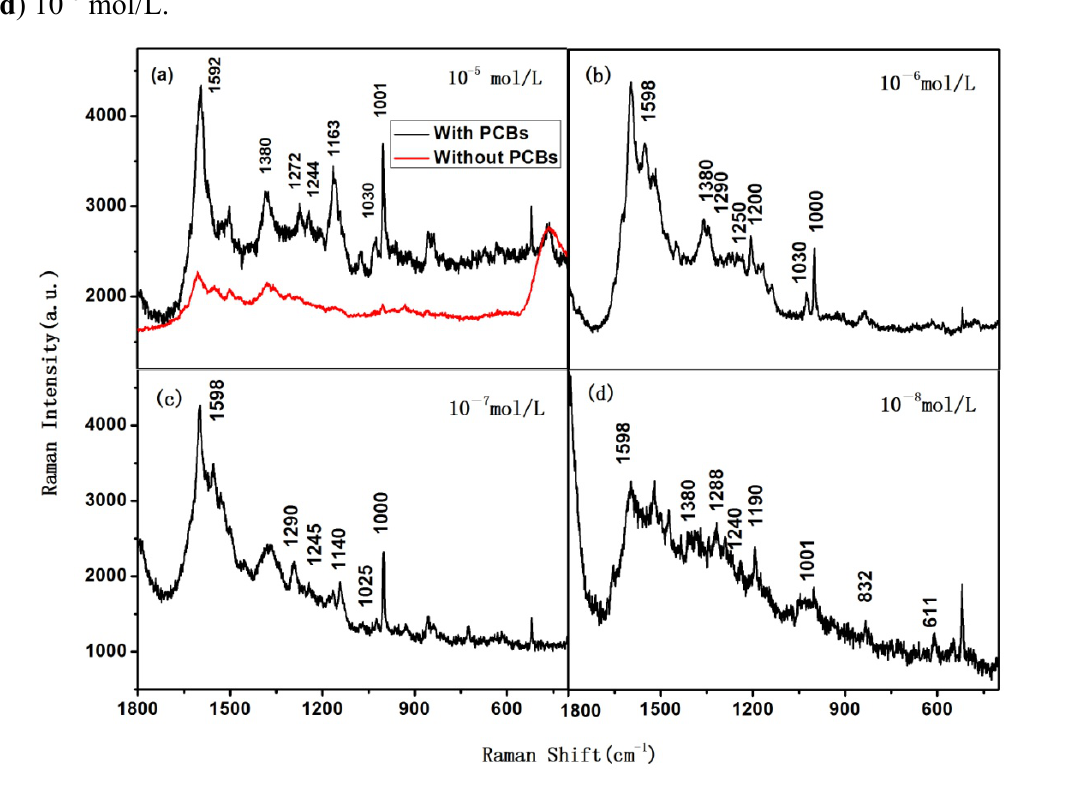
Figure 2. Raman spectra of PCBs polluted soil samples with PCBs concentration of ( a ) 10 - 5 mol/L and without PCBs for comparison; ( b ) 10 - 6 mol/L; ( c ) 10 - 7 mol/L; ( d ) 10 - 8 mol/L.